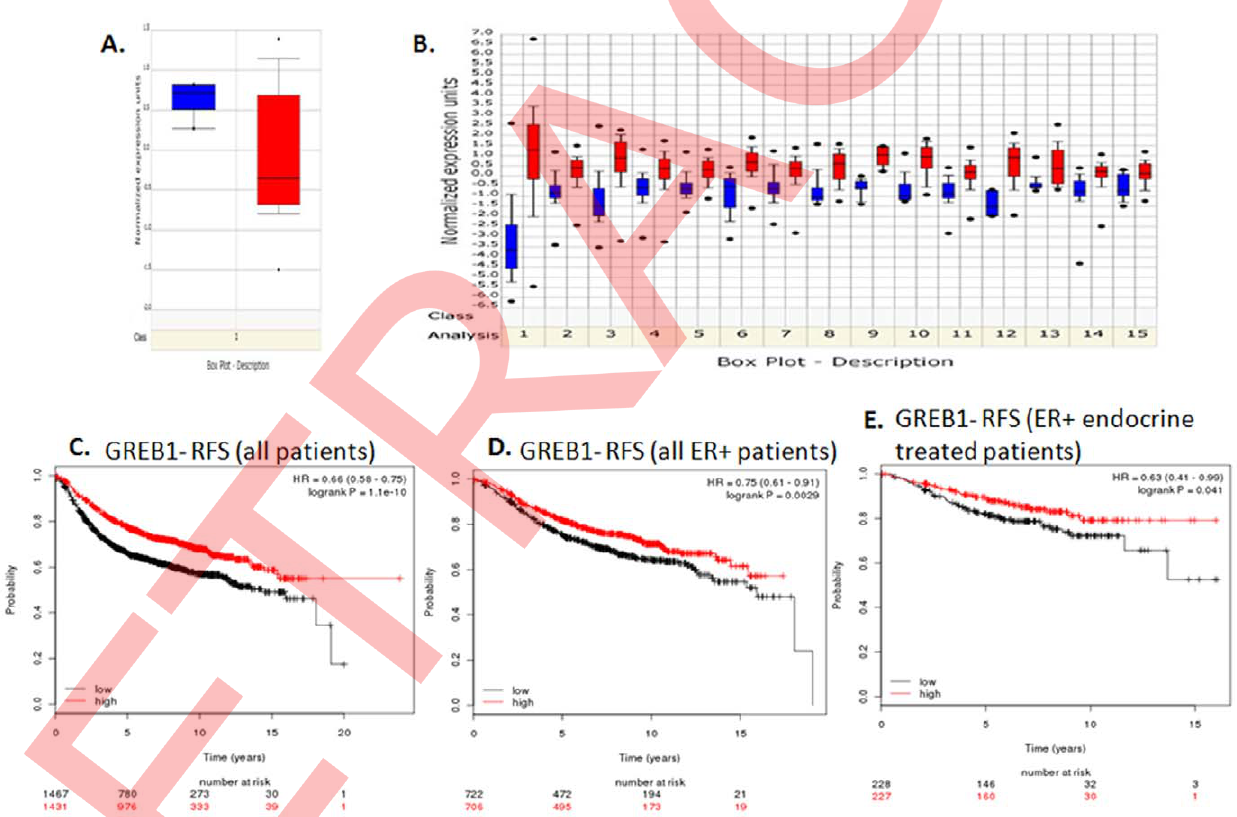
Figure 2. GREB1 mRNA correlates with ER status in breast cancer patients, and predicts responses in Tamoxifen-treated patients. Meta-analysis was performed using the Oncomine Research Platform- based microarray studies. A. Microarray analysis of 7 normal breast tissues (red bar) and 40 breast cancers (blue bar). The mean values of GREB1 mRNA expression are shown here. B. Microarray analysis of 2321 patients (1651 ER- positive, 670 ER-negative). The level of GREB1 expression is higher in ER-positive breast cancer patients, which are depicted by red-colored bars and ER-negative patients are represented by blue ones. Kaplan-Meier survival plots demonstrate the prognostic relevance of GREB1 expression on patient survival using various data cohorts. C. Reduced expression of GREB1 is predictive of lower relapse free survival (HR=0.66, p =1.1 6 10 2 10 ) for all patients; D. For ER + breast cancer patients, lower GREB1 expression is correlated with decreased relapse free survival (HR=0.75, p =0.0029); E. Endocrine treated ER + breast cancer patients have reduced relapse free survival if their tumors expressed lower GREB1 level (HR=0.63, p